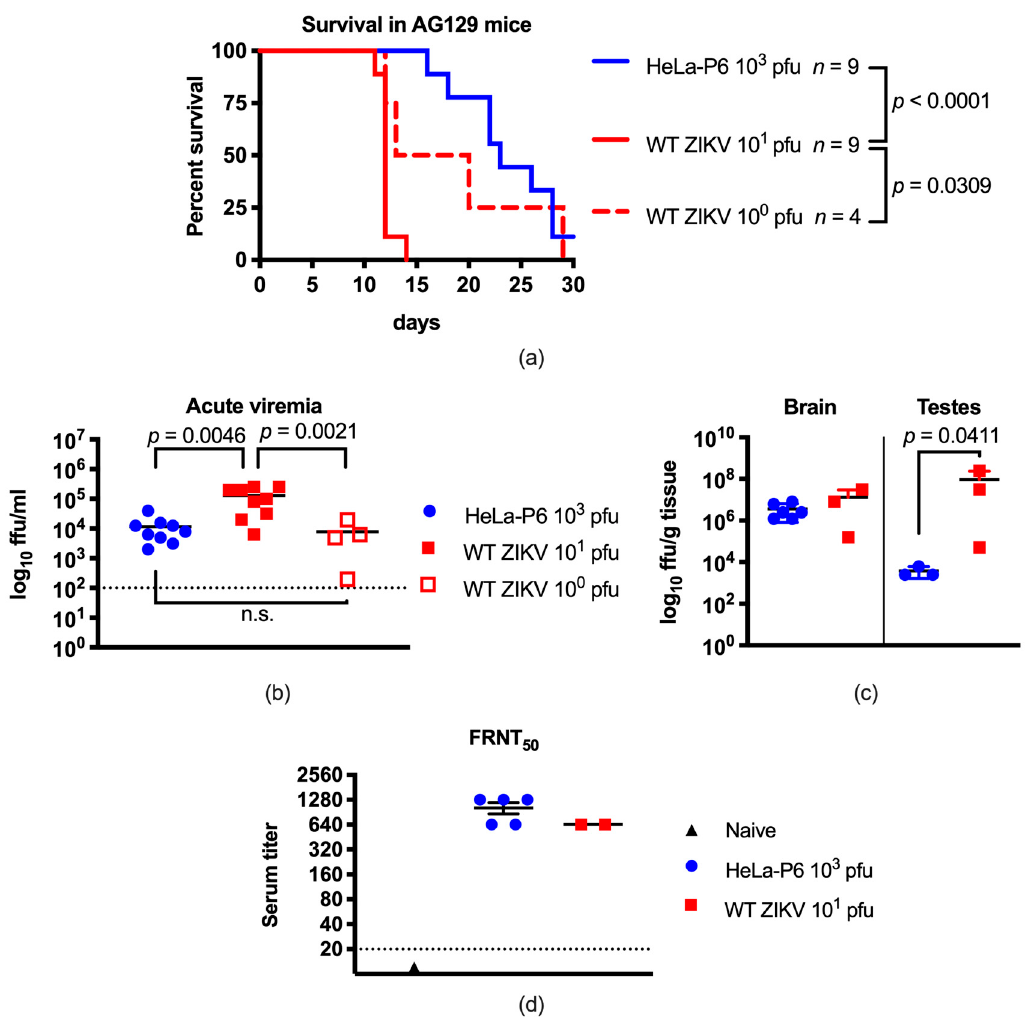
Figure 2. ZIKV passaged in HeLa cells was attenuated and generated an immune response in AG129 mice. ( a ) Adult AG129 mice were inoculated via the i.p. route with 10 0 or 10 1 pfu of WT ZIKV or with 10 3 pfu of HeLa-P6 virus, and monitored for morbidity and mortality for 30 days. Statistics were determined using Log-rank (Mantel–Cox) tests. WT ZIKV 10 0 pfu n = 4; WT ZIKV 10 1 pfu n = 9; HeLa-P6 10 3 pfu n = 9; ( b ) AG129 mice were bled 3 days p.i. to determine acute infection viremia levels. Lines indicate the mean titer. Statistics were determined using one-way ANOVA and Tukey’s post-test; n.s.: not significant. WT ZIKV 10 0 pfu n = 4, WT ZIKV 10 1 pfu n = 9, Hela-P6 10 3 pfu n = 9; ( c ) At time of death, infected animal brain and testis samples were harvested to determine viral loads. Lines indicate means. Statistics were determined using t tests. WT ZIKV 10 1 pfu days 11–12, brain n = 3, testis n = 3; HeLa-P6 10 3 pfu brain n = 6, testis n = 3; ( d ) Neutralizing antibody titers present in terminal sera from euthanized mice infected with WT ZIKV 10 1 pfu ( n = 2, 11–12 days p.i.), HeLa-P6 10 3 pfu ( n = 5, days 16–27 p.i.) or naïve ( n = 1) mice were determined using a FRNT 50 assay in Vero cells. Endpoint titers are plotted in a log 2 scale to reflect the 2-fold dilution series. Dashed line: limit of titer detection was 1:20. Results between WT ZIKV and HeLa-P6 were not significantly different by Mann–Whitney